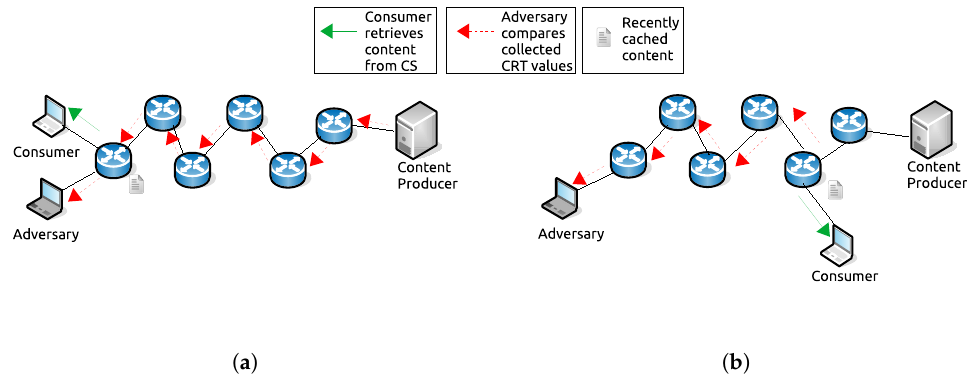
Figure 8. Attack designs and scopes: ( a ) Identifying closest hop cached contents. ( b ) Identifying distant hop cached